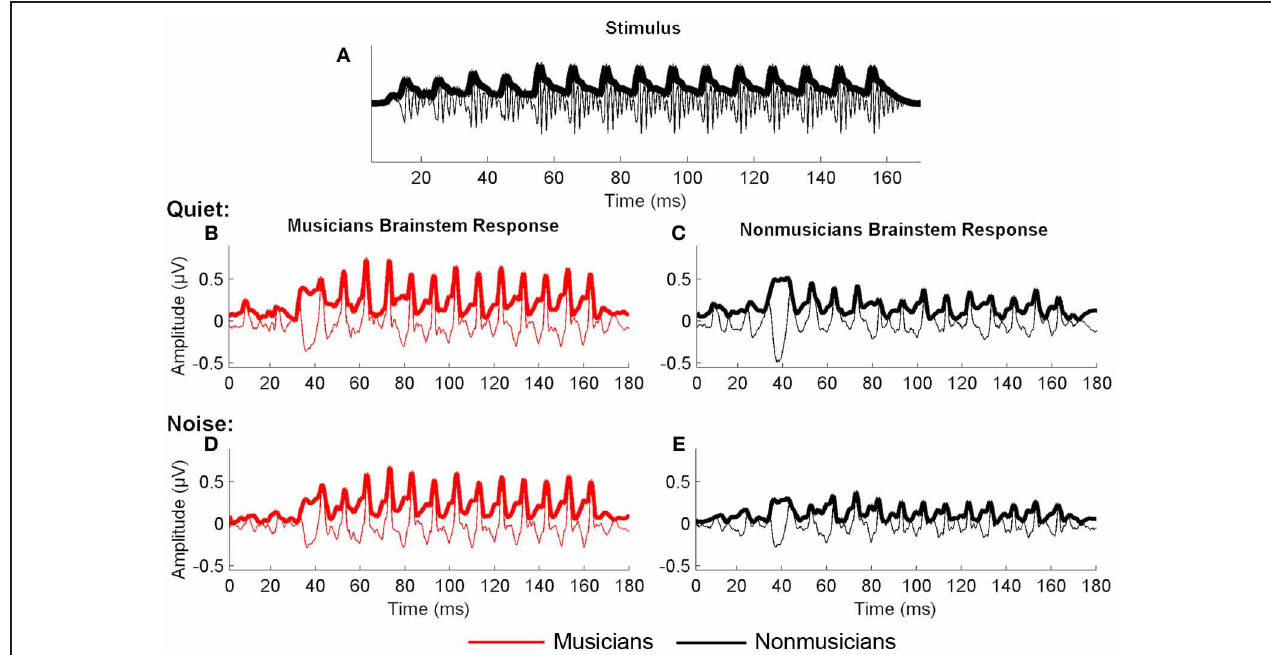
FIGURE 4 | Envelope correlations between the stimulus (A) and the responses from the two conditions: quiet (B and C) and noise (D and E). The neural encoding of the stimulus envelope was greater in musicians (red) than nonmusicians (black) for both quiet and noise.